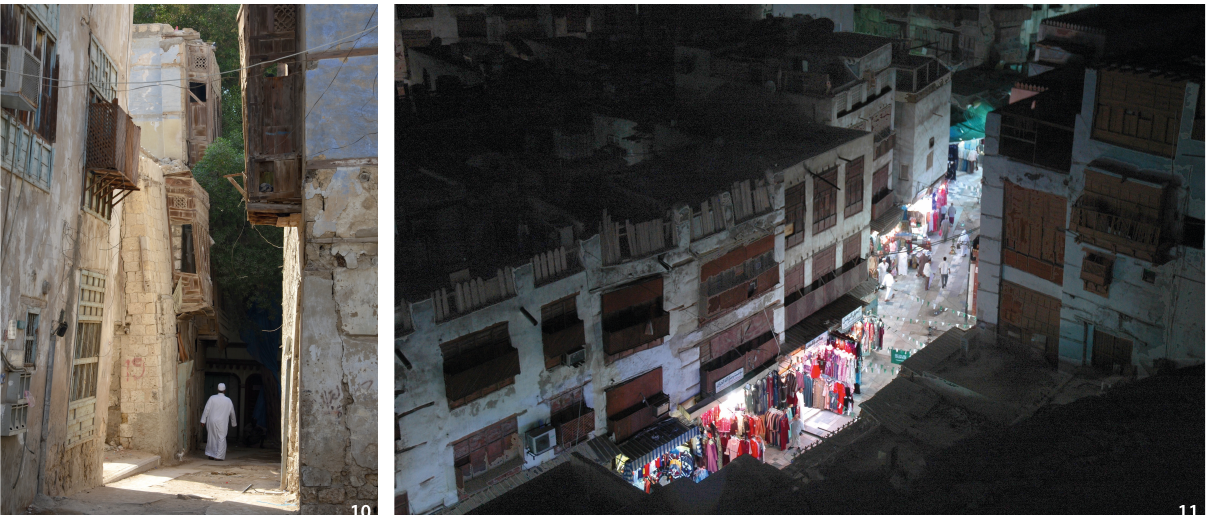
Figure 10 Decaying historic houses, 2012 (Source: F. Cristofoli). Figure 11 Old city souk by night, 2007 (Source: C.